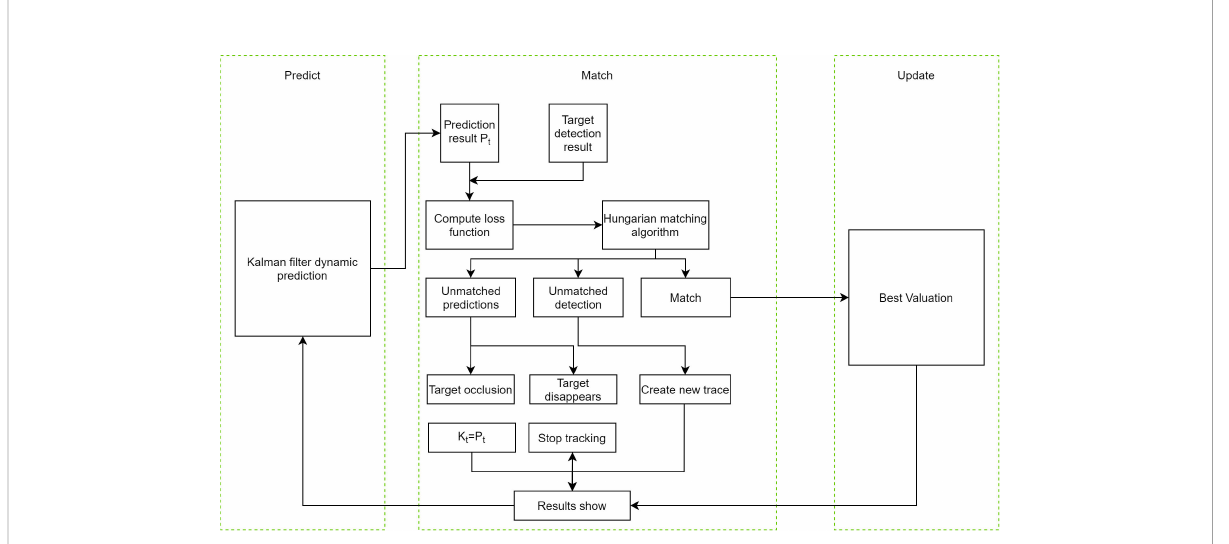
FIGURE 7 Flow chart of Kalman fi lter and Hungarian matching